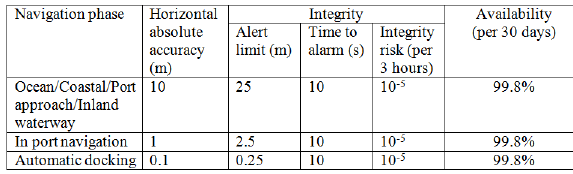
Table 1. IMO minimum maritime user requirements